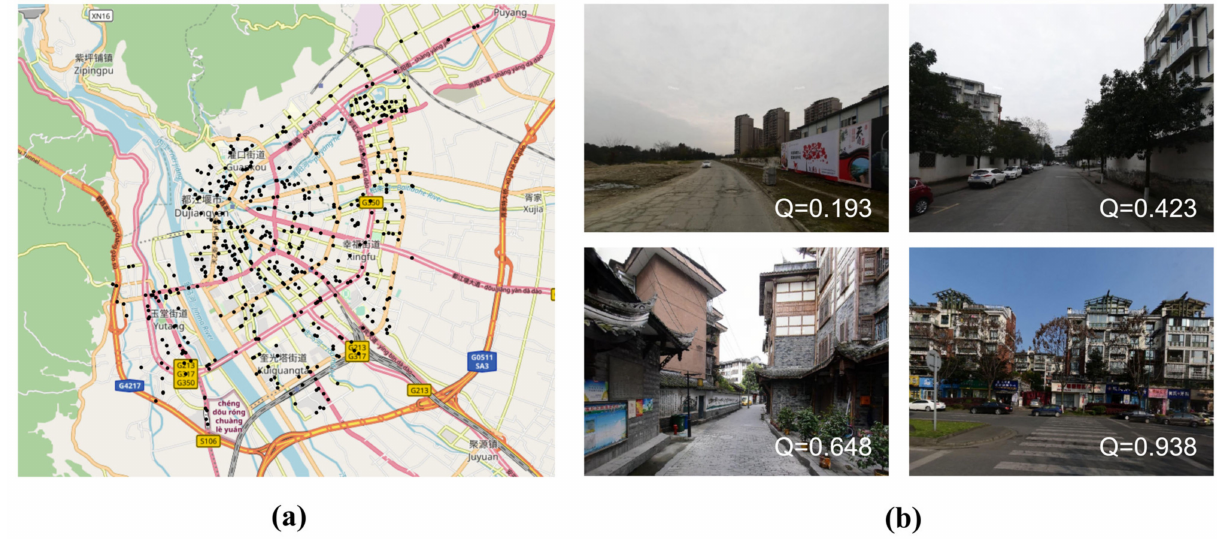
Figure 2. ( a ) The distribution of locations of selected street view images in Dujiangyan city. ( b ) Examples of normalised safety scores (represented as Q) using Trueskill and